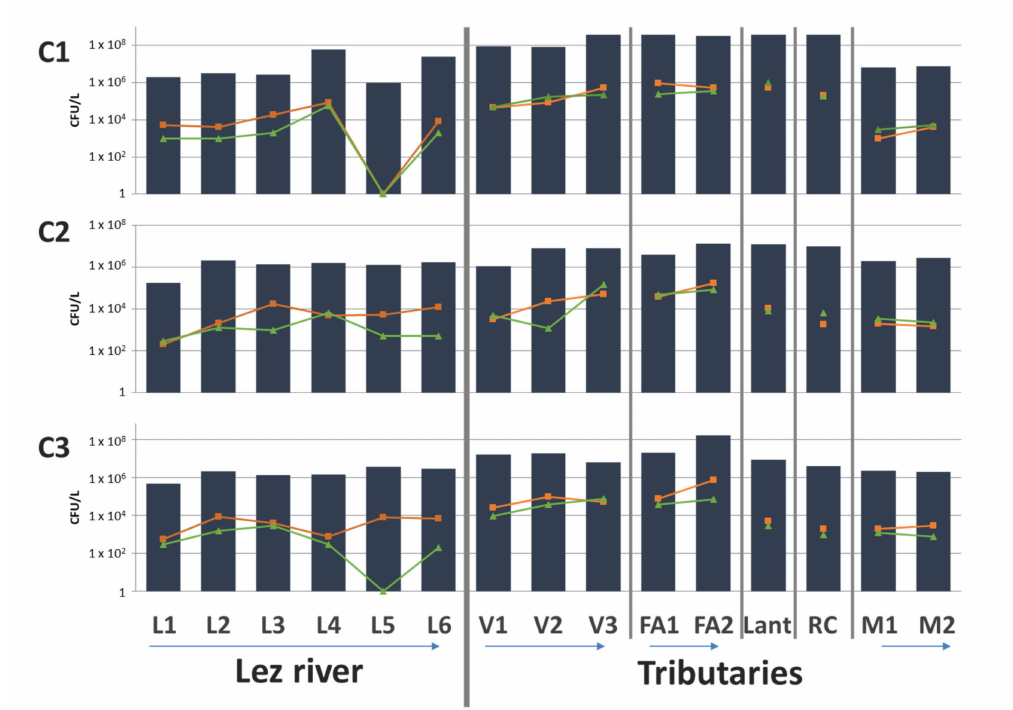
Figure 3. Enumerations of cultivable communities (black bars), thermotolerant coliforms (orange line), and intestinal enterococci (green line). Campaigns were indicated on the left (C1, C2, and C3) while sampling site were noted on the bottom. Arrows represent water flow direction. L1 to L6: Lez River; V1 to V3: Verdanson River; FA1 and FA2: Font d’Aurelle River; Lant: Lantissargues River; RC: Rieu Coulon River; M1 and M2: Mosson